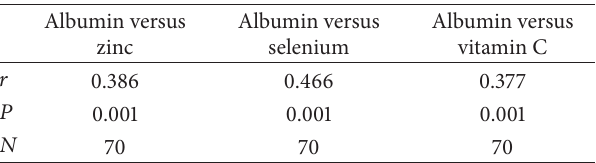
Table 3: Correlation of albumin with serum micronutrients level in HIV infected